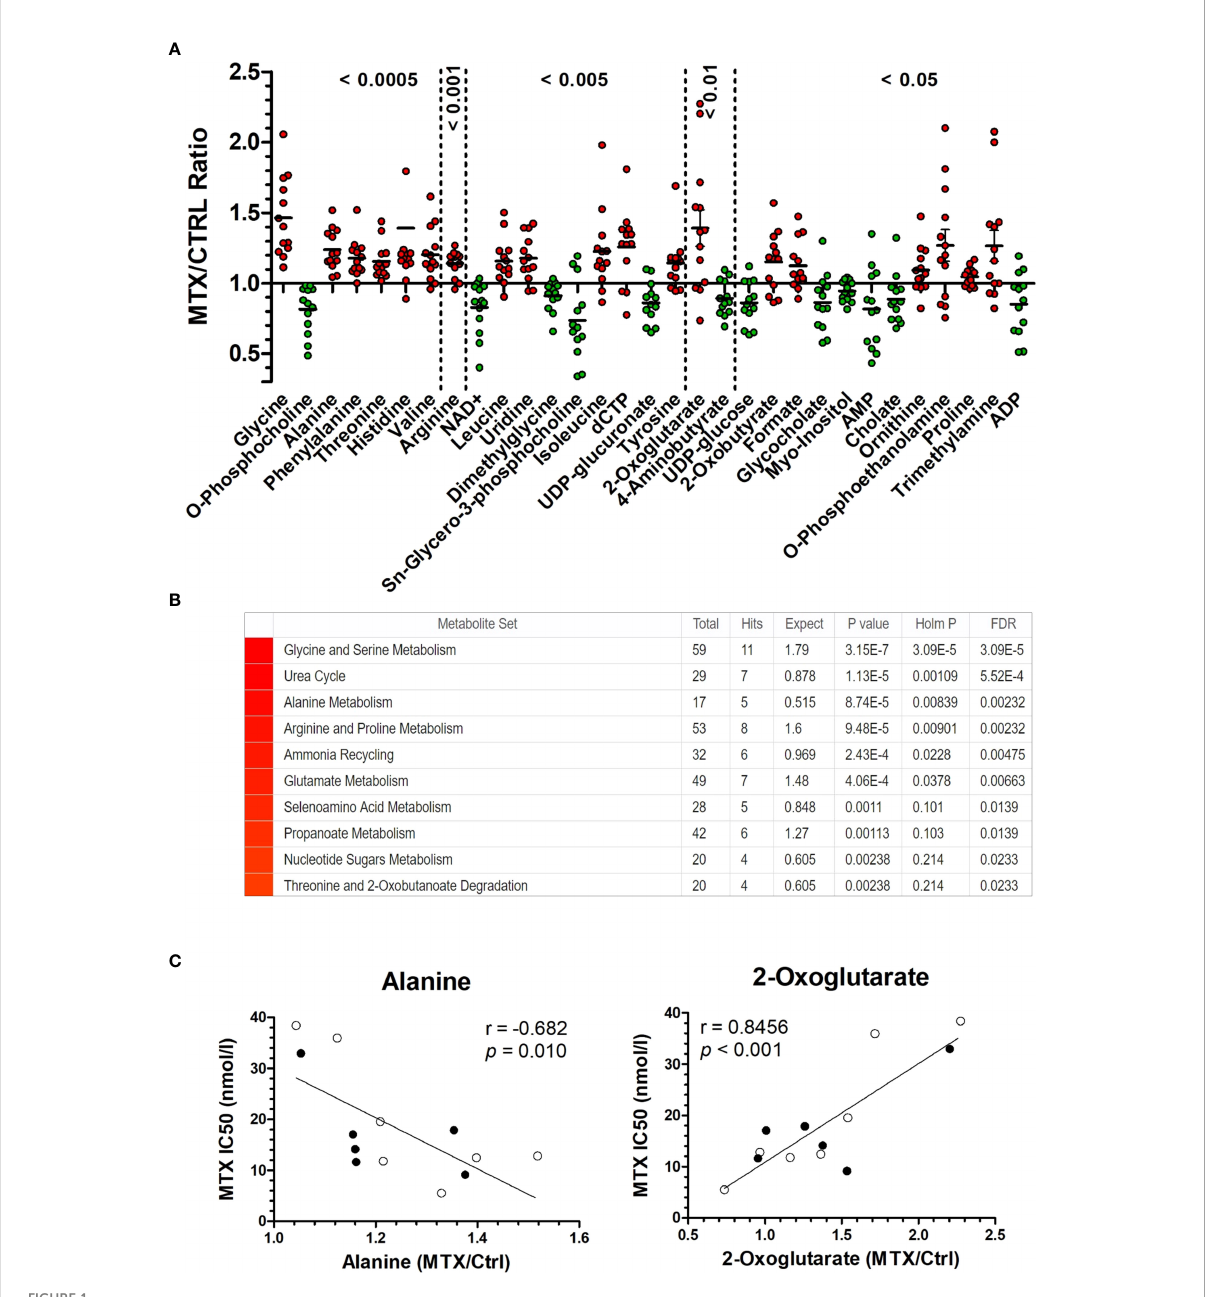
FIGURE 1 MTX-driven metabolic perturbations in ALL. (A) Metabolic disturbance caused by MTX treatment. Each dot is the mean of three biological replicates for each cell line. Metabolites ’ concentrations fold change (in MTX-treated/untreated cells) above 1 indicate increase caused by MTX, whereas values below 1 indicate antifolate-induced decrease ( P -values, Wilcoxon signed ranked test, after comparison of the distributions with the hypothetical mean value of 1). (B) Enrichment score for metabolites in (A) indicate the metabolic pathways and processes most impacted by MTX. (C) Correlation between metabolite concentration in untreated cells and MTX resistance (IC50 at 96 hours). Black and white beads represent BCP-ALL and T-ALL cell lines, respectively. P -values and r are from Pearson